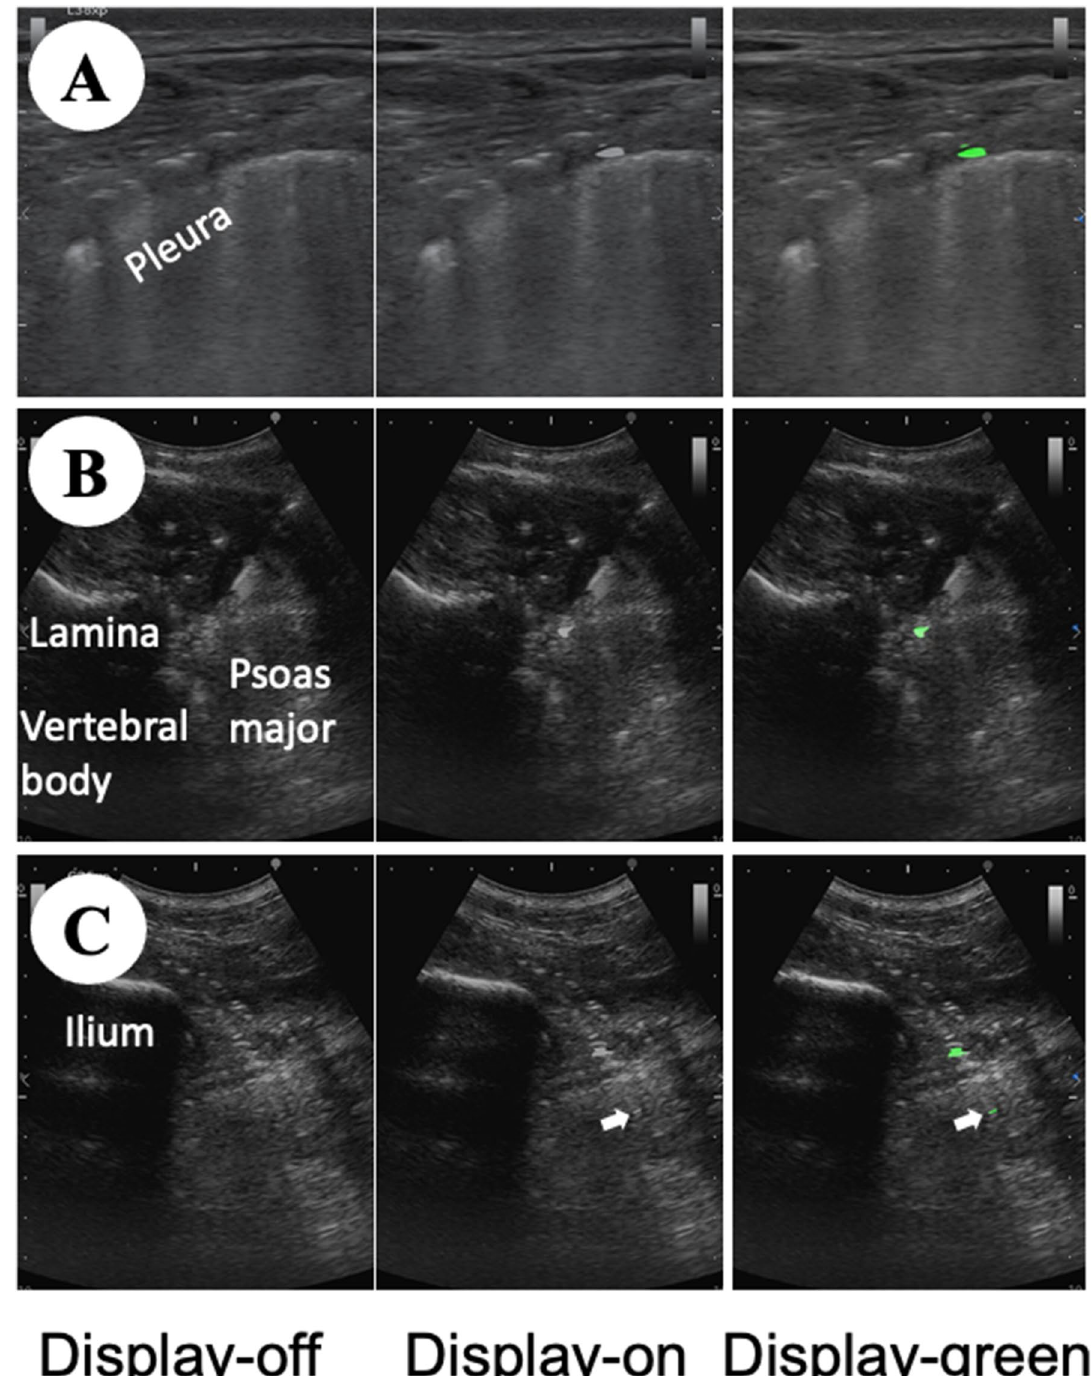
Figure 3. Ultrasound views of nerve blocks. The pictures show nerve blocks (at right side of cadaver). These pictures are all obtained using the photoacoustic needle. The picture of display-off does not show the photoacoustic ultrasound, the pictures of display-on and display-green show the photoacoustic ultrasound. Mirror image artifact of the needle tip is observed in the display-on and display-green of the ( C ) (white arrows indicate the mirror image artifact). ( A ) paravertebral block ( A ), ( B ) lumbar plexus block, ( C ) sciatic nerve block, display-off: no photoacoustic ultrasound, display-on: photoacoustic ultrasound using white color, display-green: photoacoustic ultrasound using green color (See Supplemental Digital Contents nos. 13, 15 and